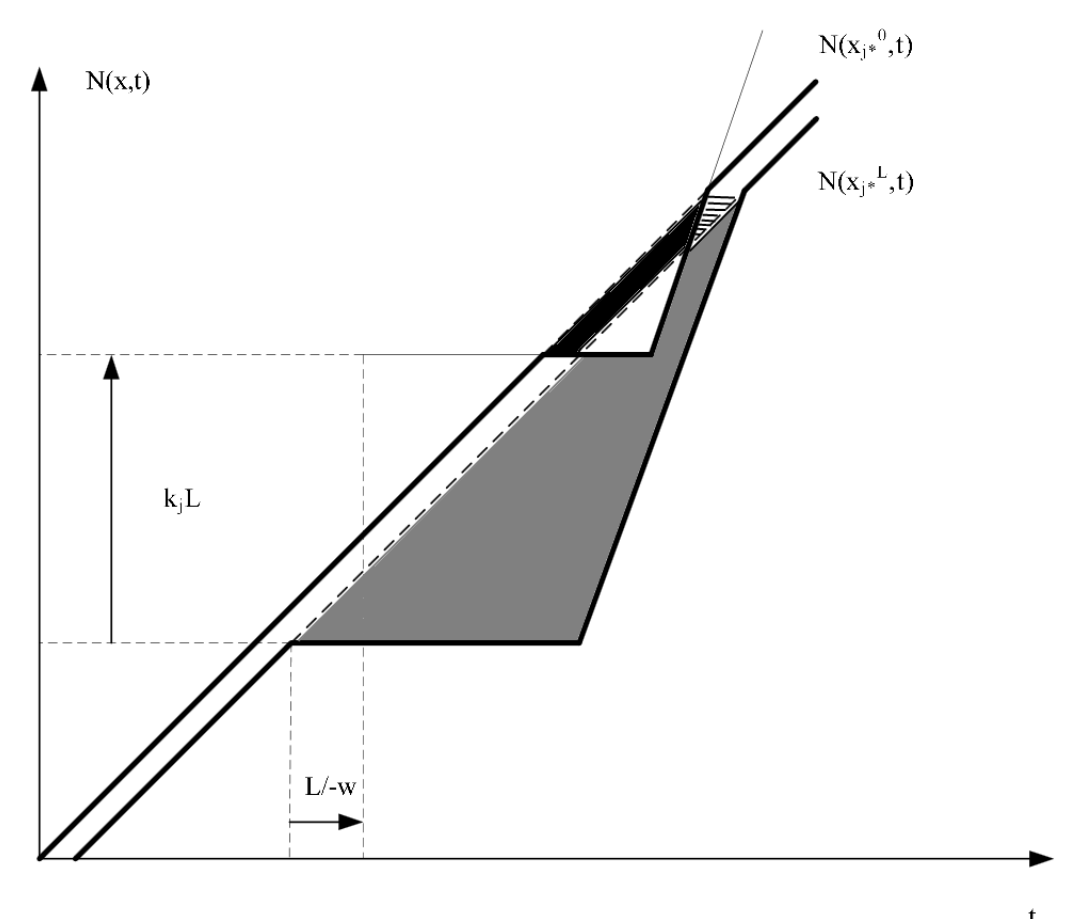
Figure 2. Approximation of the effects of disturbances (Corthout et al.,2009)